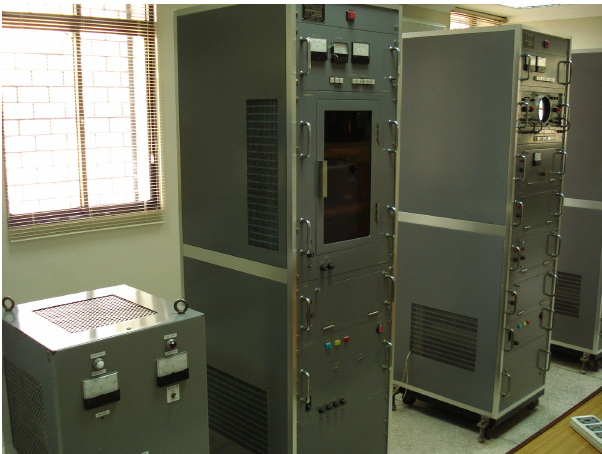
Figure 2. An image of the Panoramic Ionospheric Recorder-9